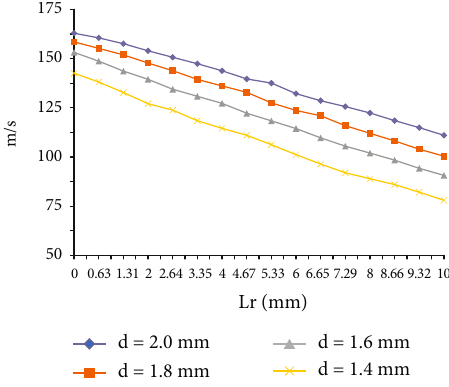
9: Velocity distribution of the water jet on the central